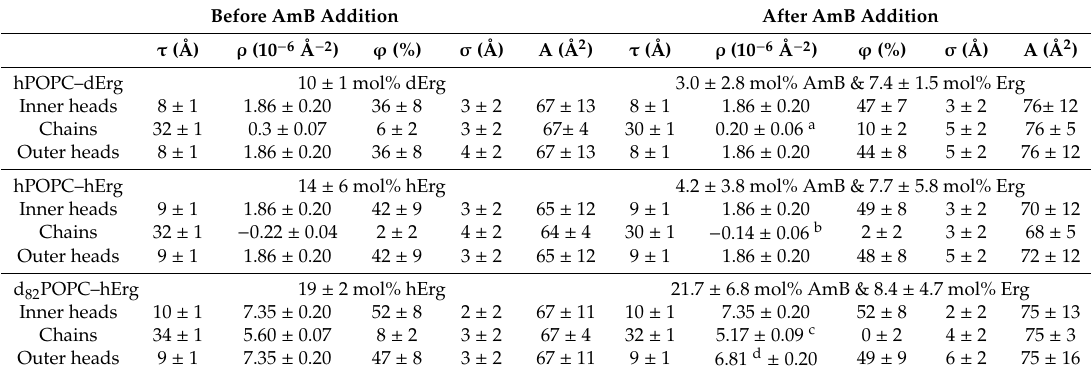
Table 3. Parameters corresponding to the best fits to the data from POPC–ergosterol bilayers before and after AmB addition, as displayed in Figure 2.